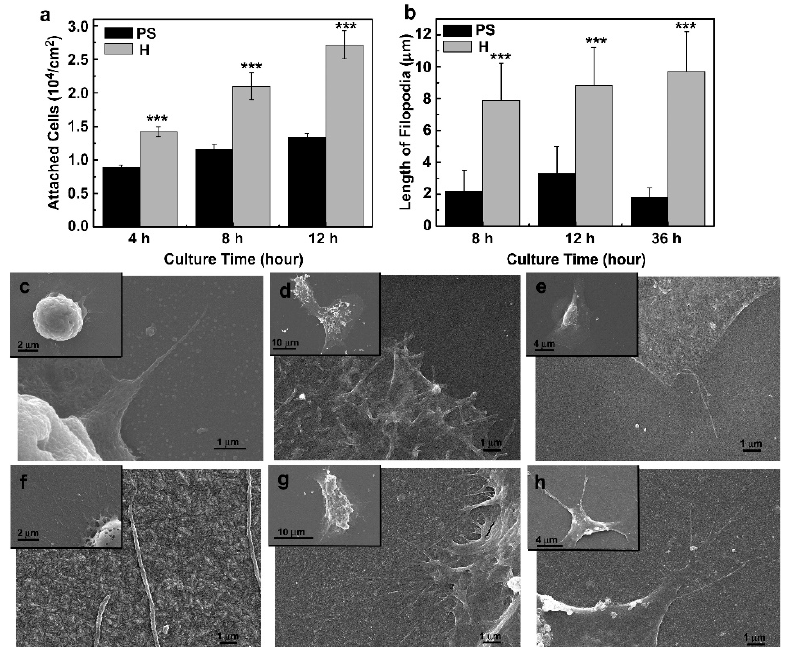
Figure 4. Comparison of: ( a ) adhesion of neural stem cells (NSCs) (from a seeding density of 3.5 × 10 4 cells/cm 2 ) to a polystyrene (PS) Petri dish (black bars) and to H-UNCD films (grey bars), with data expressed as mean ± standard deviation ( n = 4); ( b ) length of filopodia (100 nm in width) of NSCs cultured on polystyrene (black bars) and H-UNCD films (grey bars), in supplemented medium, at 8, 12, and 36 h of culture. More than 30 cells were randomly picked and measured for each sample by an unbiased investigator who was not informed of the nature of each sample. SEM micrographs, at low (inset) and high magnification of NSCs cultured for 8, 12, and 36 h, on: ( c – e ) polystyrene, showing short filopodia with few protrusions that do not spread far from the main cell body; ( f – h ) H-UNCD, showing numerous, long and complex filopodia that extend away from the main cell body. Significance levels: *** p < 0.001 [6] .